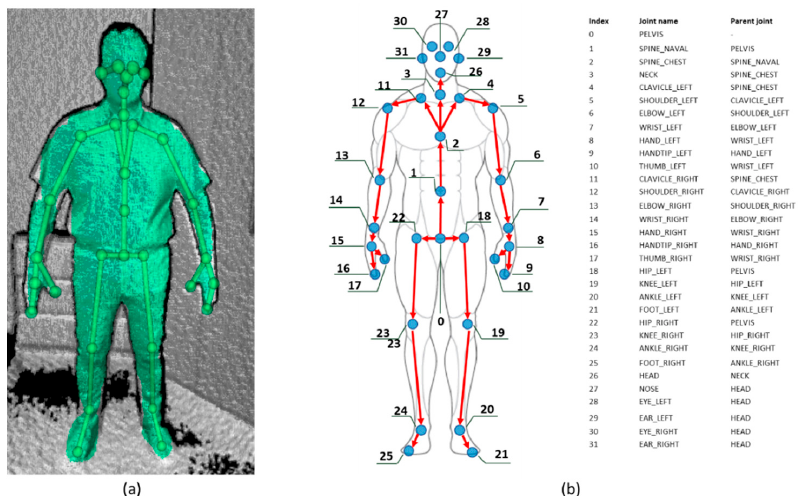
Figure 3. The data returned by the Microsoft Azure Kinect Body Tracking Software Development Kit. ( a ) The surface and the skeleton visualized by the Azure Kinect Body Tracking Viewer; ( b ) joint positions and respective parent joint in the joints’ hierarchy.